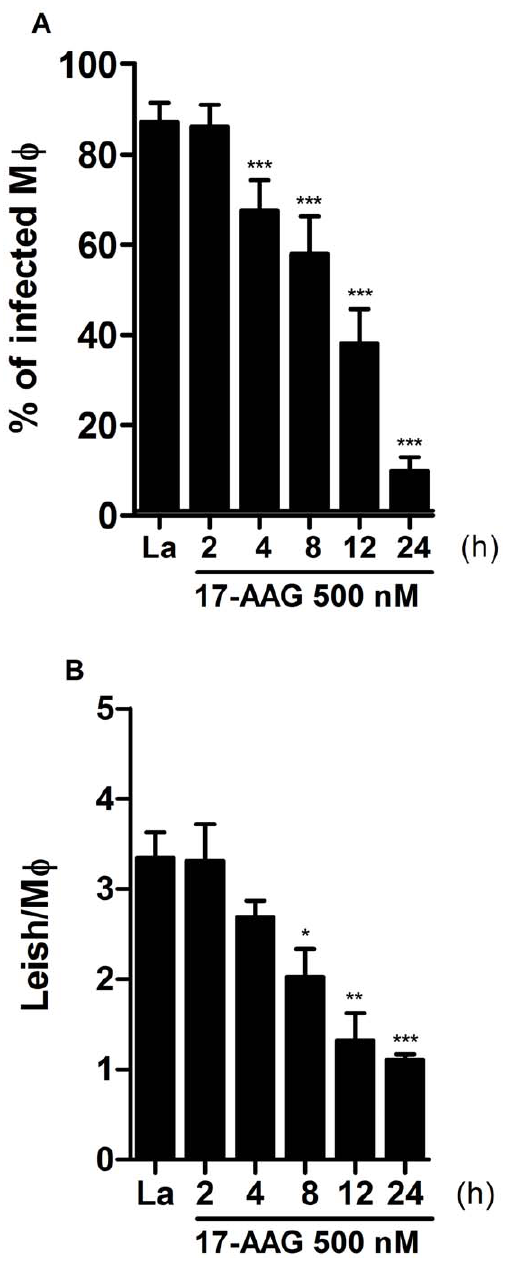
Figure 2. Irreversibility of treatment with 17-AAG on in- tracellular Leishmania . To assessment the reversibility of parasite growth inhibition by treatment with 17-AAG parasite load was determined by quantifying the percentage of infected macrophages ( A ) and the number of parasites per macrophage ( B ) as described in Materials and Methods. Bars represent means 6 SD of one represen- tative experiment out of two performed in sextuplicate (one-way ANOVA, *** p , 0.0001, Dunnett’s Multiple Comparison Test, * p , 0.05, ** p , 0.001, *** p , 0.0001, post-test for linear trend, p , 0.0001).